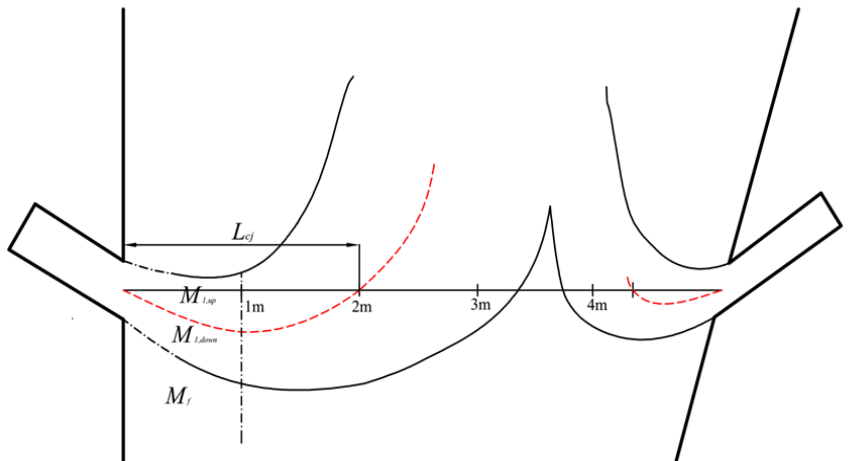
Figure 5. The schematic diagram of the SA jet trajectories. (red line: schematic diagram of secondary air flow trajectory)